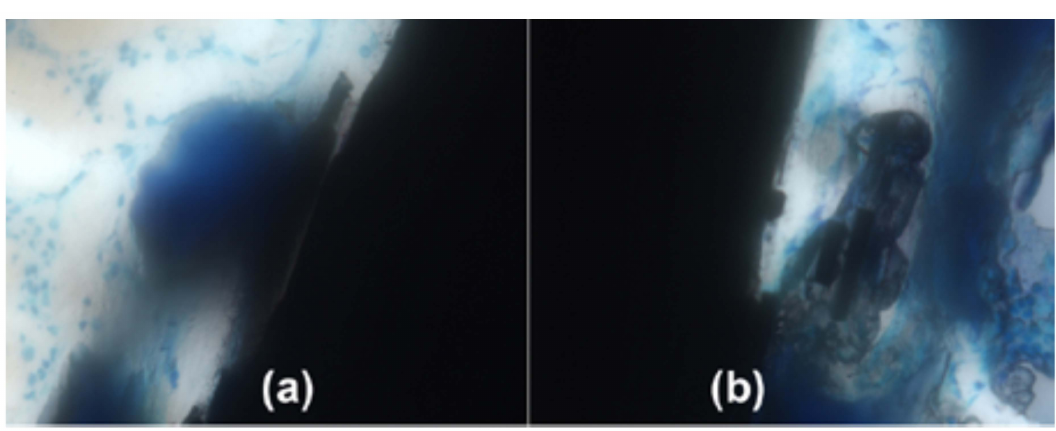
Figure 4. Lateral histology section at 40X magnification by toluidine blue stain for epoxy/ carbon-fiber-reinforced composite implant with carbon fibers cleaved and pulled perpendicularly away from the implant. ( a ) Carbon fibers are cleaved transverse to the long direction of the unidirectional composite implant; ( b ) Bone osseointegrates completely around small carbon fiber fragments.